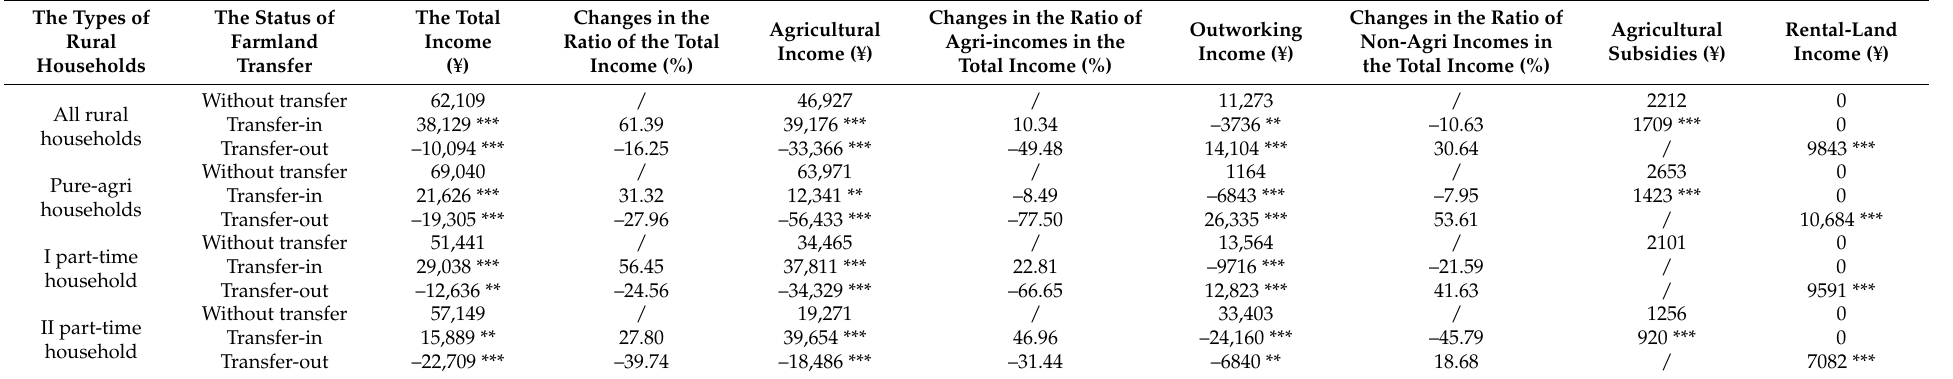
Table 6. Comparison of changes in the income structure of different rural households after transferring-in or transferring-out of